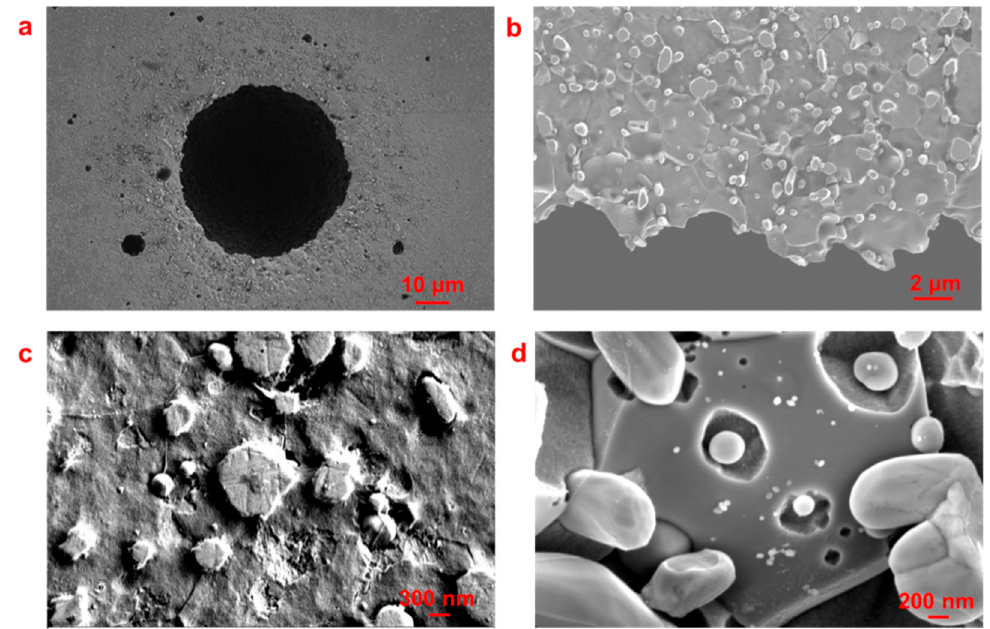
Figure 6. ( a ) SEM image of a pit with a corroded circumference, ( b ) higher magnification image of the corroded circumference of the pit, ( c ) the corroded outer part of the pit ring, and ( d ) SEM image of the pit bottom.